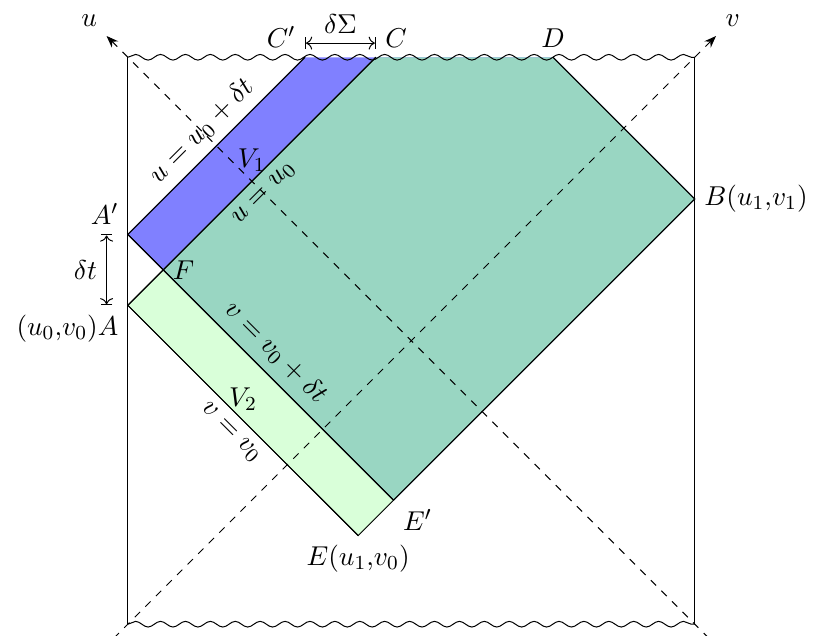
Figure 2. Illustration of the change of the WDW patch after evolving t L by (cid:14)t . The Penrose diagram for an EMD black hole shares a similar structure to that of the AdS-Schwartzschild black hole, and the deviation does not a(cid:11)ect the analysis